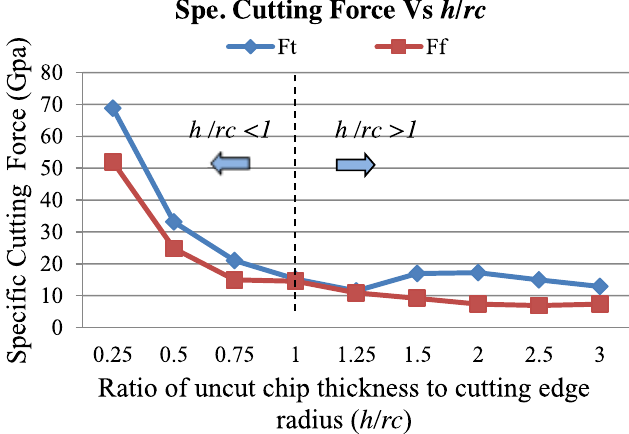
Fig. 7. Variation in speci fi c cutting forces with ratio of undeformed chip thickness to cutting edge radius.